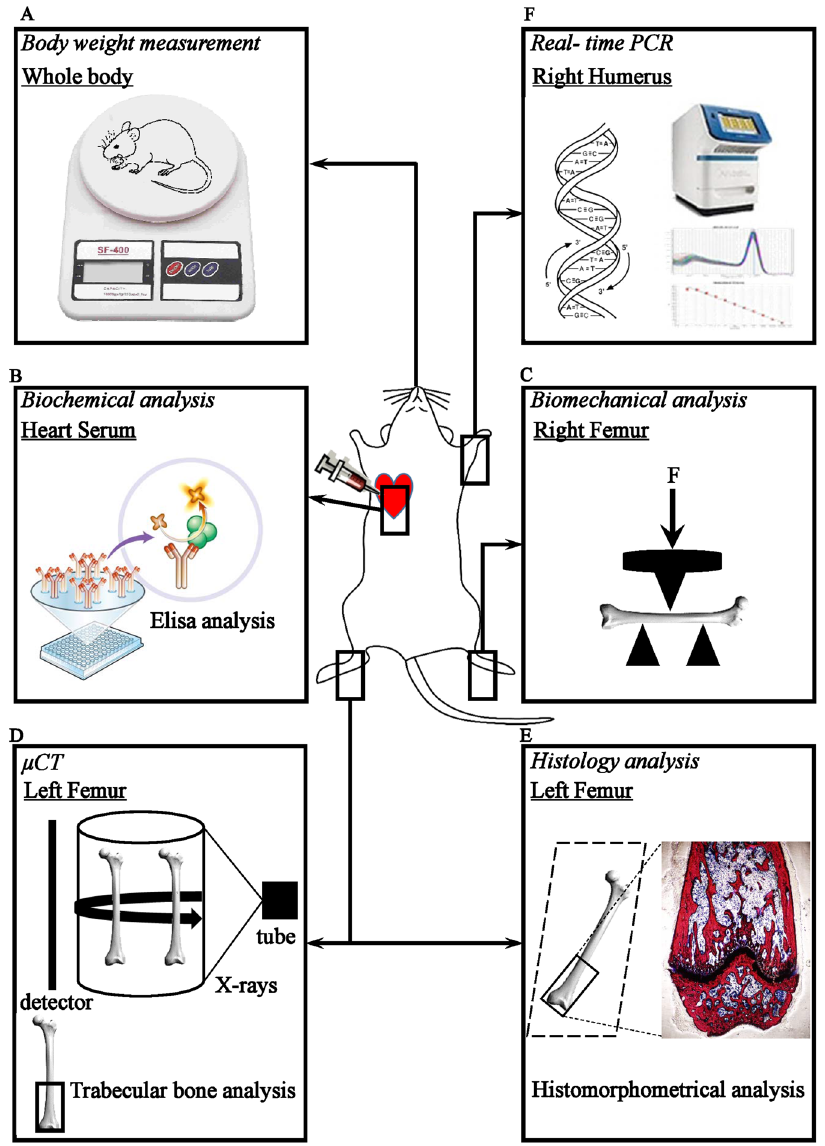
Figure 3. The integral flow chart of in vivo experiment. ( A ) Body weight measurement. ( B ) Biochemical analysis of serum. ( C ) Biomechanical examination of right femur. ( D ) µ CT analysis of left femur. ( E ) Histology and histomorphometry of analysis of left femur. ( F ) Real-time PCR of right